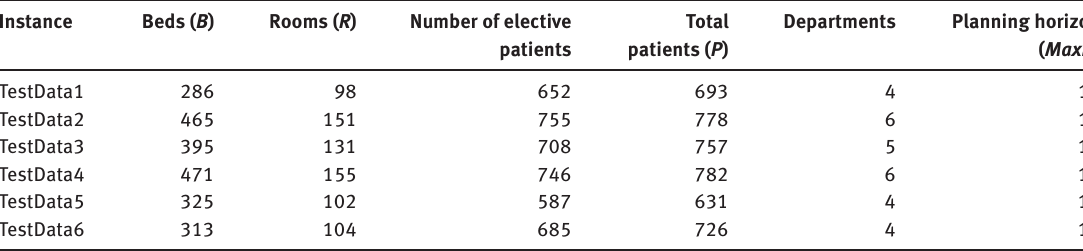
Table 2: Characteristics of the Benchmark